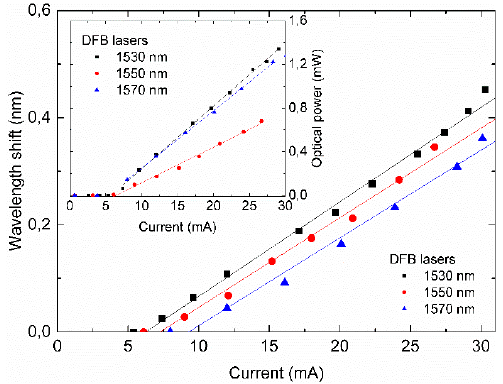
Figure 7. Effects of different values of the supplied current for the three laser diodes in terms of wavelength shift and optical power (inset).